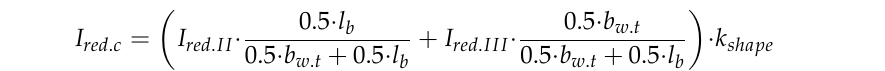
Figure 10. Scheme to determine the position of section II-II. where I red . II is the moment of inertia of the transformed cross-section determined in section II-II about the axis of the centre of gravity of the transformed cross-section; and I red . III is the moment of inertia of the transformed cross-section determined in section III-III about the axis of the centre of gravity of the transformed cross-section. Coefficient k shape evaluates the ratio of the areas of regions ( A crv and A tr ); there, the mixture law is used to determine I red . c . The void quarter was transformed into the rectangular and roundness was not